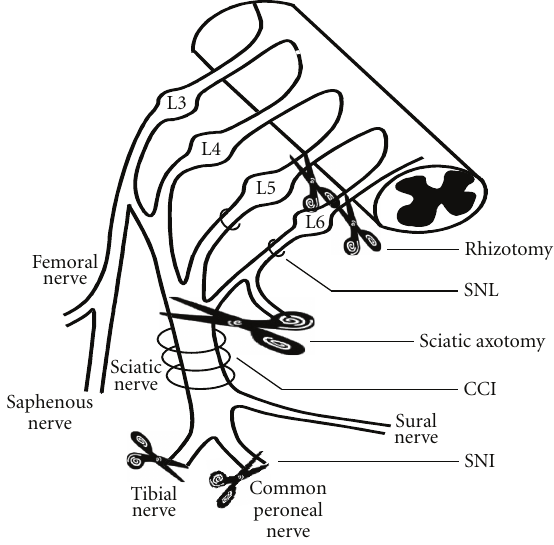
Figure 1: Schematic of the major animal models of nerve injury. Rhizotomy consists of section of dorsal roots; SNL: spinal nerve ligation, usually L5 or L5 and L6; CCI: chronic constriction injury consists of loose ligations of the sciatic nerve; SNI: spared nerve injury, consists of section of the tibial and the peroneal branches leaving the sural